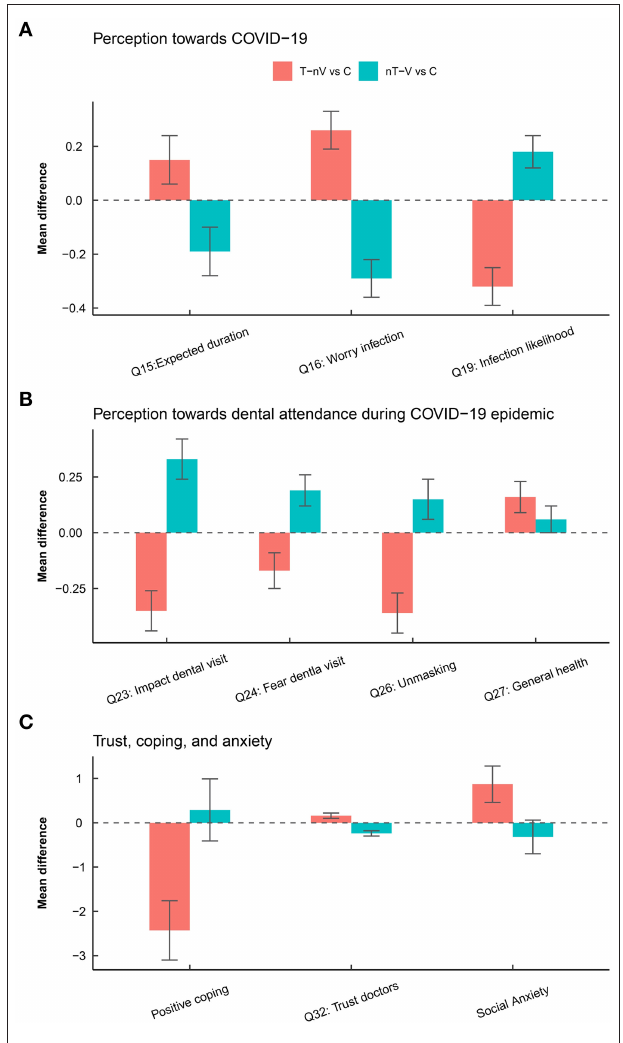
FIGURE 2 | Differences in the response of participants among the four behavioral groups. (A) Difference in perception toward COVID-19. (B) Differences in perception toward dental attendance during the COVID-19 epidemic. (C) Differences in coping, trust, and social anxiety.